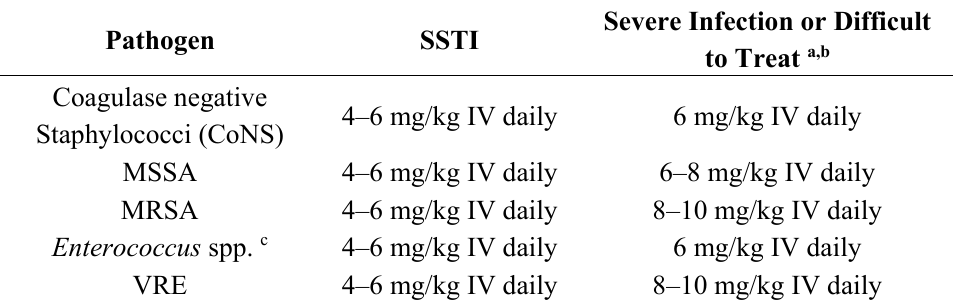
Table 1. Daptomycin dosing